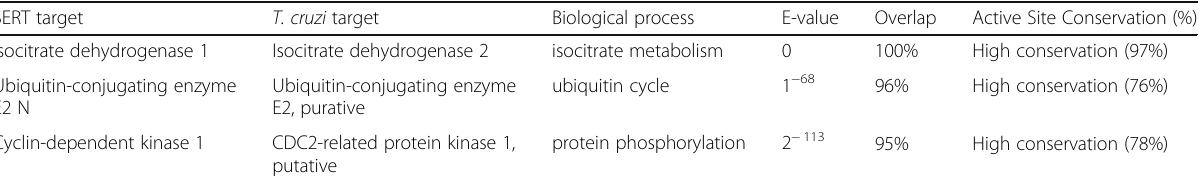
Table 2 List of potential sertraline targets in T. cruzi